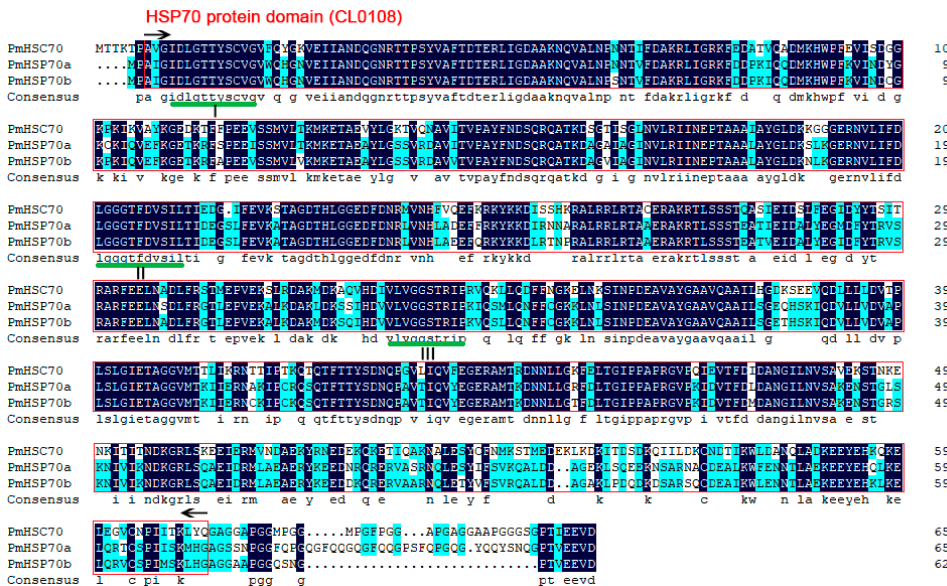
Figure 1. The alignment of amino acid sequences of PmHSC70, PmHSP70a, and PmHSP70b. The three signature sequences of HSP70 homologs are underlined. The conserved HSP70 protein domain (CL0108) is shown in the box. The final consensus sequence EEVD is at the C-terminus.